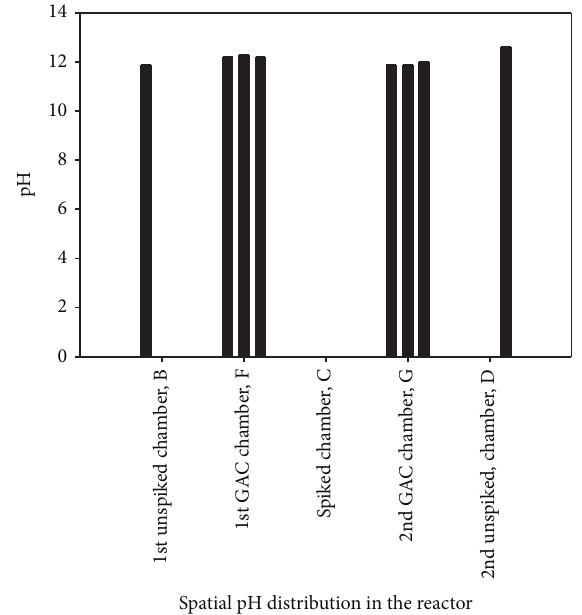
Figure7:pHprofilewithtwoGACtreatmentzonesforinvestigating bipolar effects